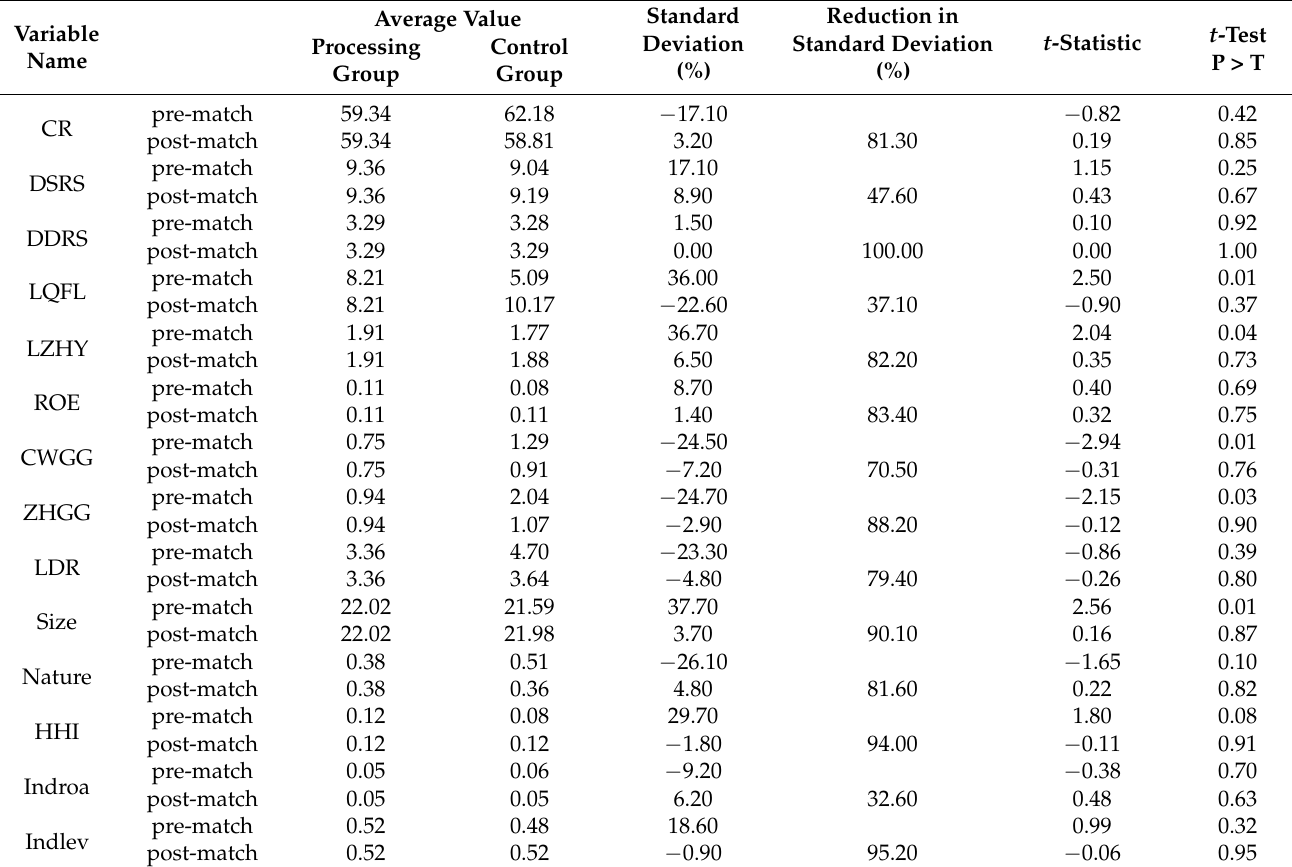
Table 6. Propensity score matching balance test,